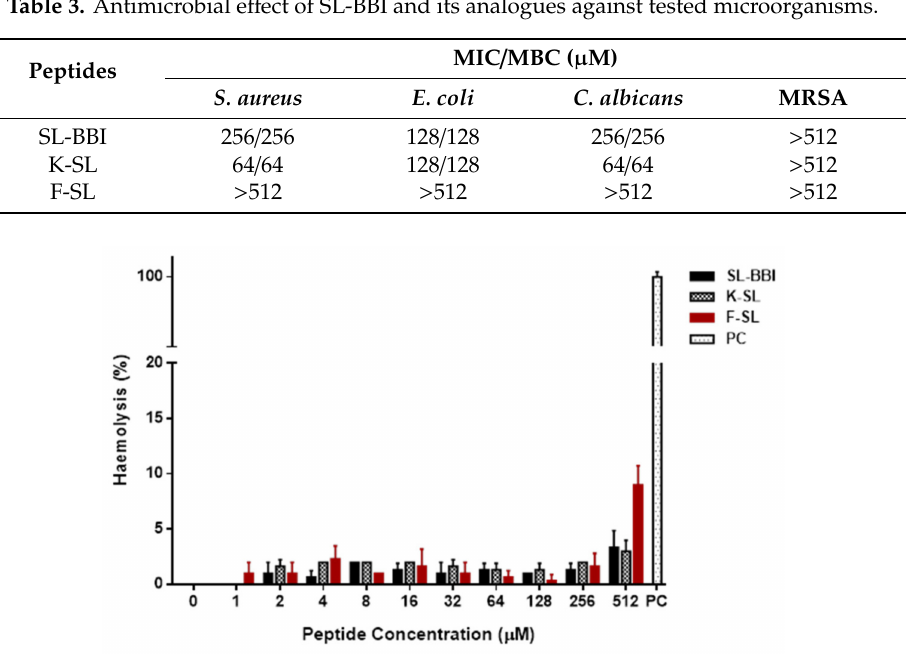
Figure 5. The hemolytic e ff ect of SL-BBI, K-SL and F-SL against horse erythrocytes after 2 h incubation. The positive control group was incubated with 1%( v / v ) Triton X-100. The error bar represents the S.E.M. (standard error of the mean) of 5